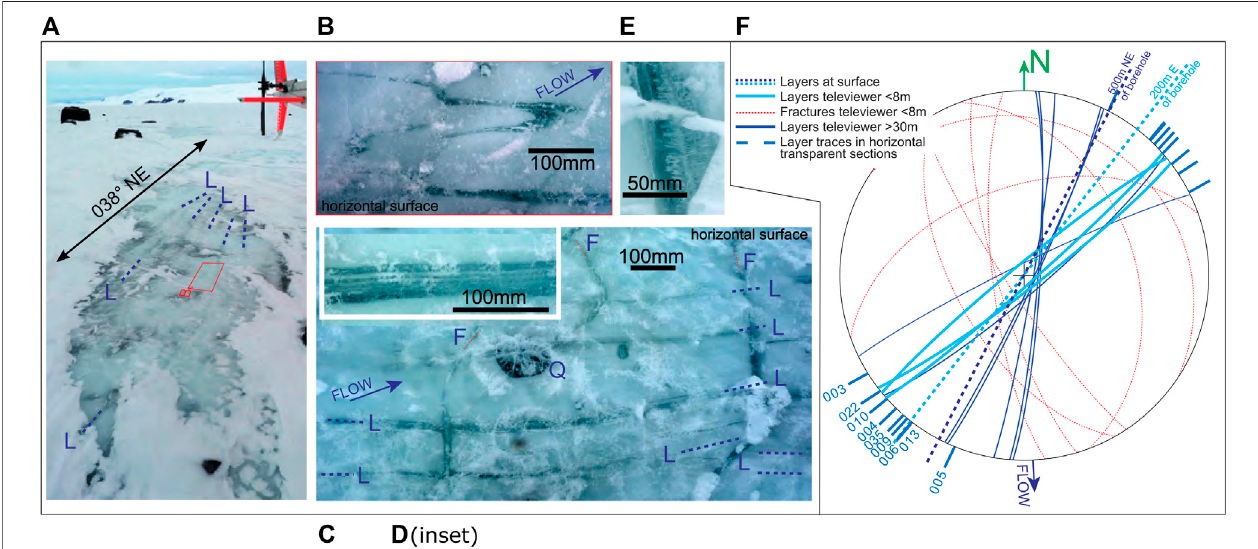
FIGURE6| LayersandfracturesinthePriestleyGlacierice,see Figure1 formapofboreholelocation. (A) Sub-vertical( ± 10 ° fromvertical,orlookingdownontothe surface) layers (blue dash lines: L) with strikes 20 – 30 ° clockwise of fl ow, exposed over several meters of a horizontal blue ice surface approximately 200 m east of the borehole. (B) Close up of folded layer (red box in a.). (C) Layers (blue dash lines: L) and fractures (Red dash lines: F) photographed in a horizontal blue ice surface approximately 500 m NE of the borehole. There are many fi ner, less obvious layers sub-parallel to those marked. Layer orientation varies across the picture. At the bottom right a set of fi ner layers ( fi ne lines) are truncated by coarser layering oriented about 20 ° clockwise (coarser line). The surface also contains circular frozen melt ponds,orcrystalquirks(Q). (D) Closeupoflayeringfromjustoutsideofpicture(C).Indetaillayerscomprisemultiplebandsofafewmmtoafewtensofmminthickness. (E) Close up of a fracture (extension out of picture of the right hand fracture in C) showing bubble trails radiating from a medial line. (F) Lower hemisphere, equal-area stereonet with layers and fractures plotted as great circles. Dashed blue great circles show the average layer orientations from sites shown in A and C. Solid blue great circlesaredistinctplanarfeaturesidenti fi edintheteleviewerdata:thoseshallowerthan8 m(lightblue)correspondtolayersidenti fi edincorethatareverysimilartothose seen in surface ice. Red-dashed lines are indistinct (or, dark, not clearly de fi ned) planar features that occur only in the upper 8 m and correspond to distinct fractures in the core. Layers identi fi ed below 30 m are in dark blue. Traces of layering identi fi ed in cross polarized light imaging of ∼ 5 mm horizontal slices from the core are marked outside the primitive of the stereonet and are labeled by the core number (see Figure 3 , Supplementary Table S1 for